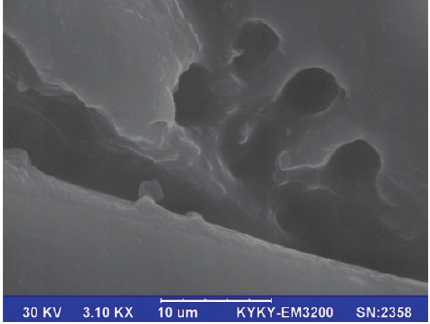
Figure 3: SEM of foaming structure of the composite at 3.10kx.